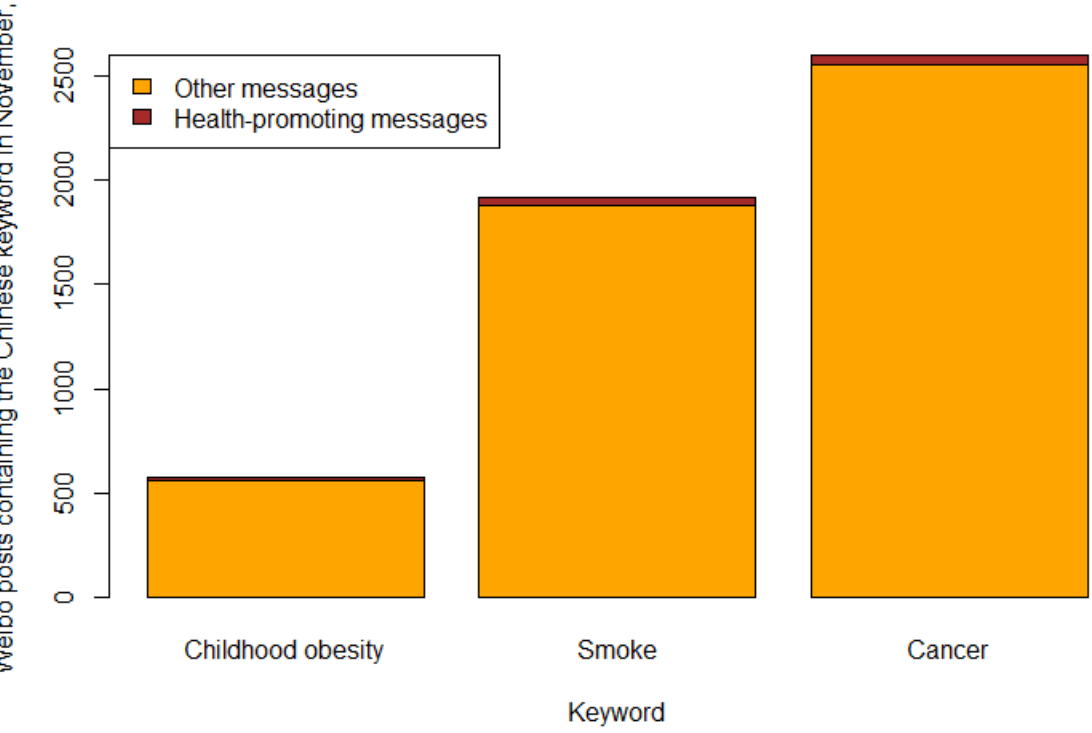
Figure 1. Number of Weibo messages that contained the Chinese keyword in the Weibo database in November 2019. Health-promoting message content had to include health-related behaviors and the consequences of